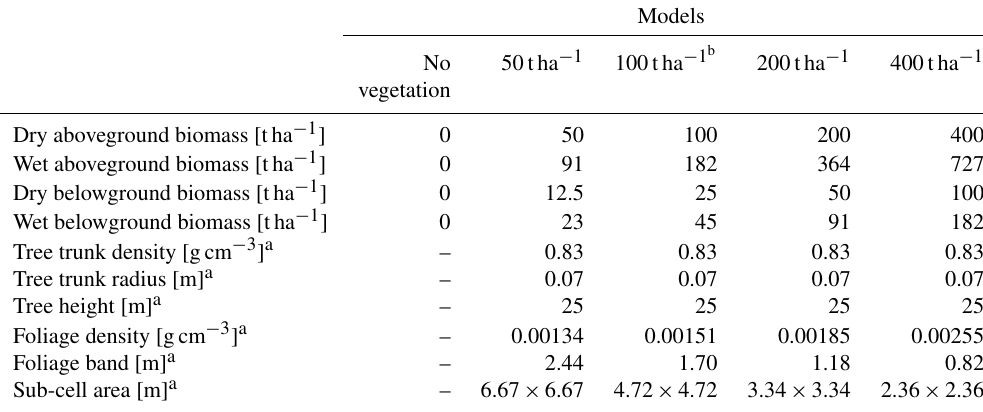
Table 4. Forest properties used in modeling.